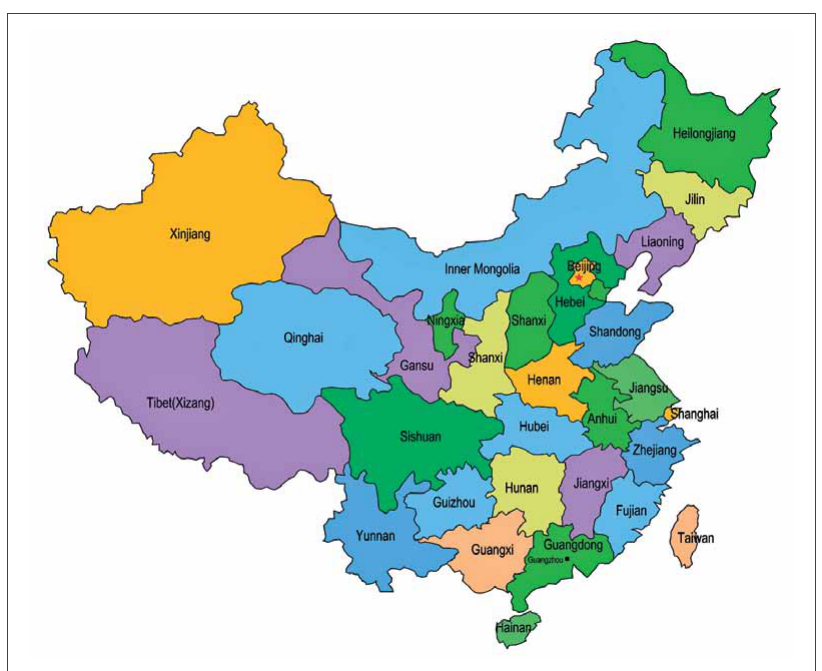
Fig 1. Map of China: locations of provinces, autonomous regions and